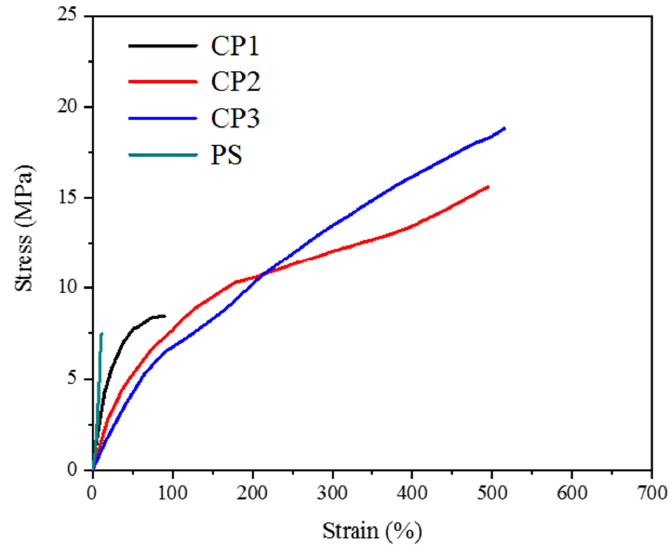
Figure 5. Stress-strain curves of copolymers with different ETPU contents.